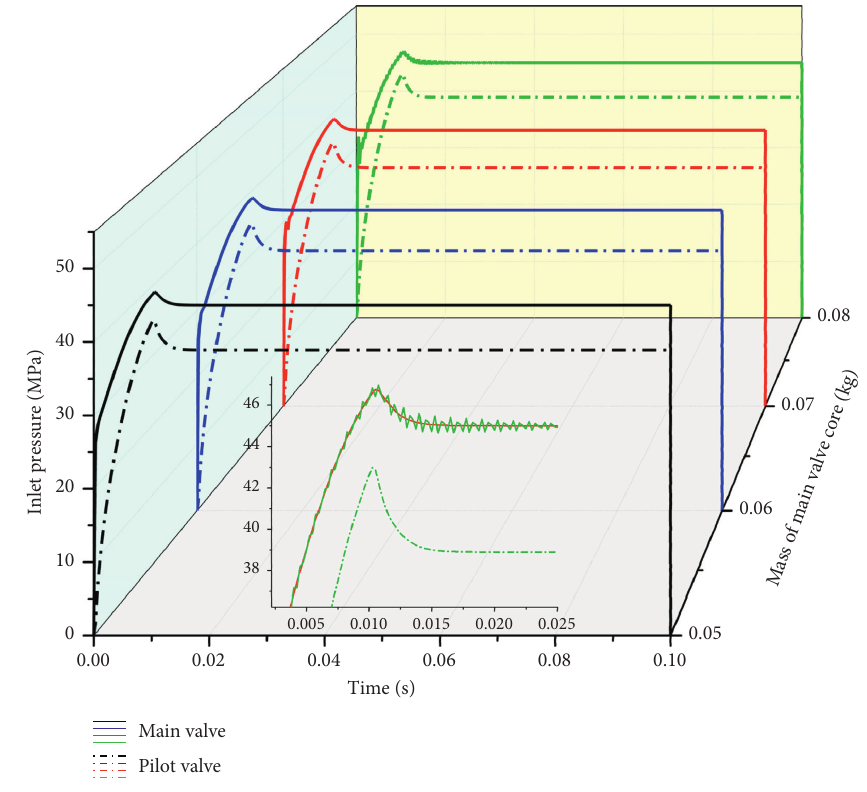
Figure 14: Influence of main valve-core mass on pressure.